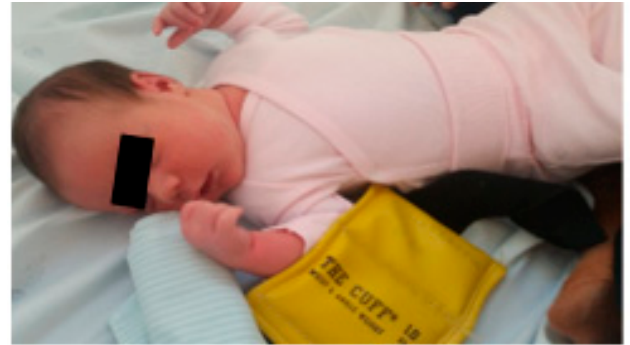
Figure 2. Weight to maintain posture.